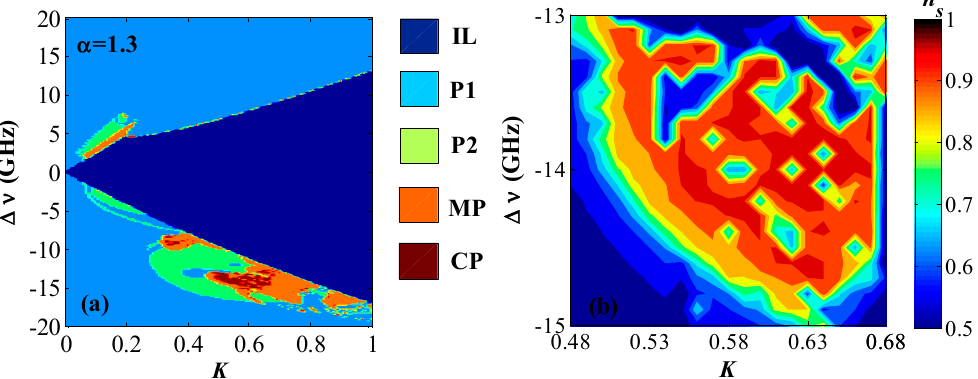
Figure 5. ( a ) Nonlinear dynamics distribution and ( b ) corresponding chaotic region complexity distribution of the ES-QD laser in the parameter space of injection coefficient and frequency detuning. IL: injection locking, P1: period one, P2: period two, MP: multi-period, CP: chaotic pulsation.